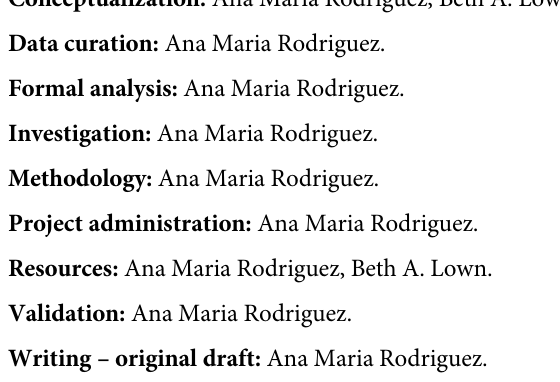
S2 Table. Cognitive debriefing methods, participant characteristics and results. S3 Table. Wording, syntax and semantics of the